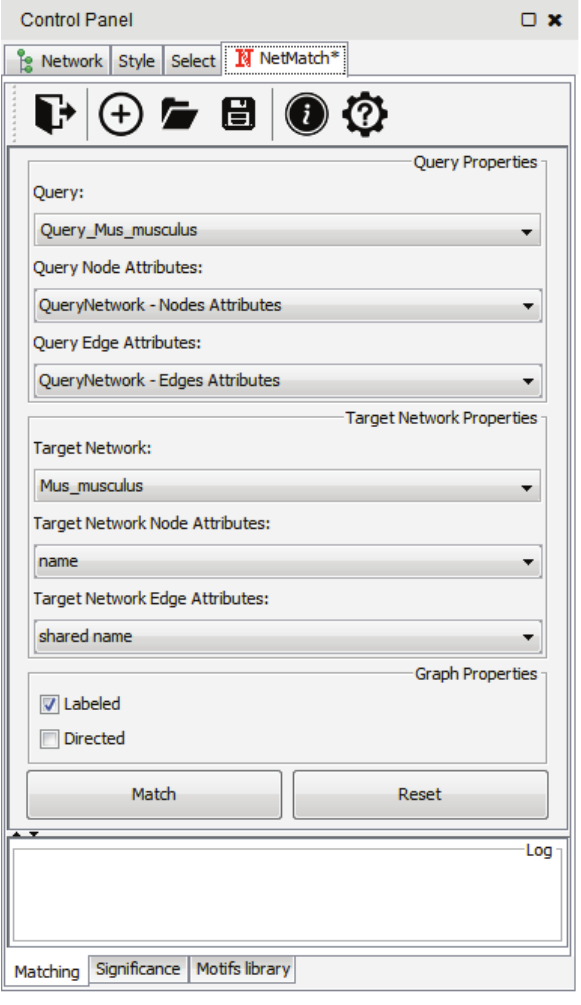
Figure 1. “Matching” panel in NetMatchStar. In this example, the network of Figure 4 has been provided as query, while the Mus musculus network provided in 24 has been chosen as target graph.